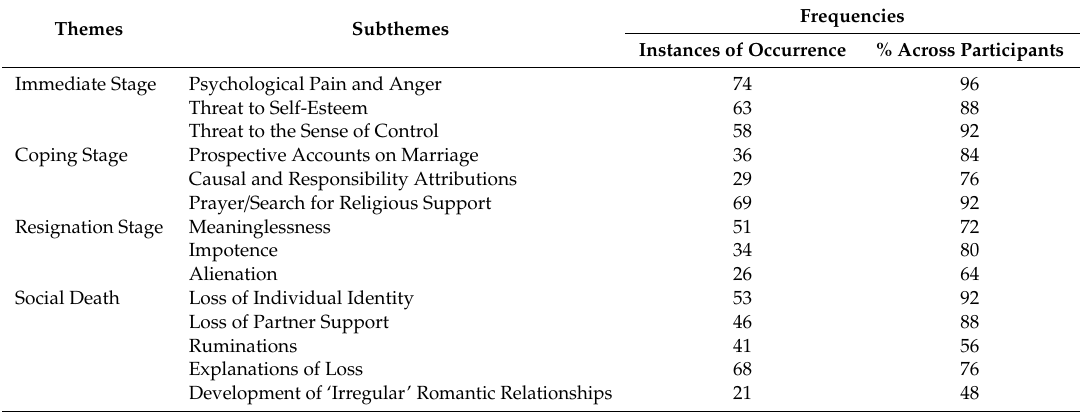
Table 1. Ostracism in Marriage.